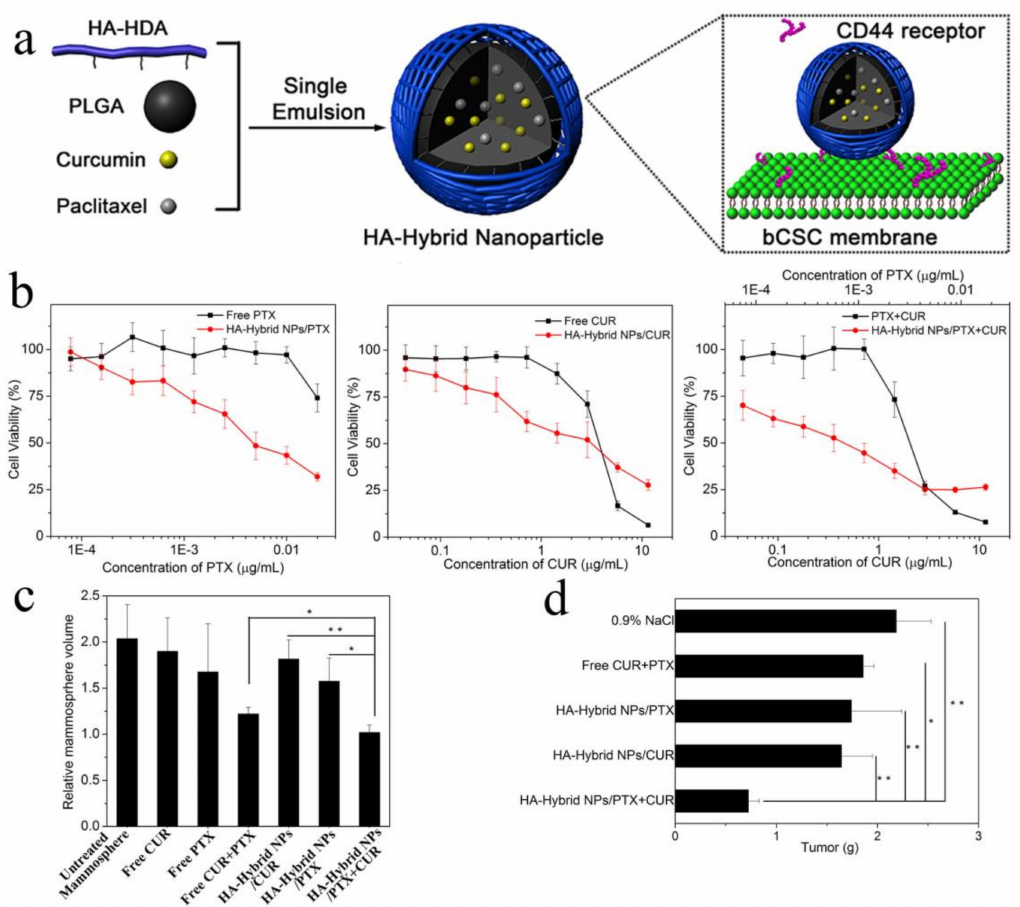
Figure 2. ( a ) Schematic illustration of composition/structure of the HA-Hybrid NPs, and its binding to CD44 on breast cancer stem cells (bCSCs); ( b ) The cell viability of MCF7 mammosphere cells after treated with different drug formulations at varying concentration for 48 h; ( c ) the relative volume of the mammosphere at the end of treatment (volume normalized to that at 0 day); ( d ) the tumor weight at the experimental end point (20th day); reproduced with the permission from [75], Copyright (2017) The Royal Society of